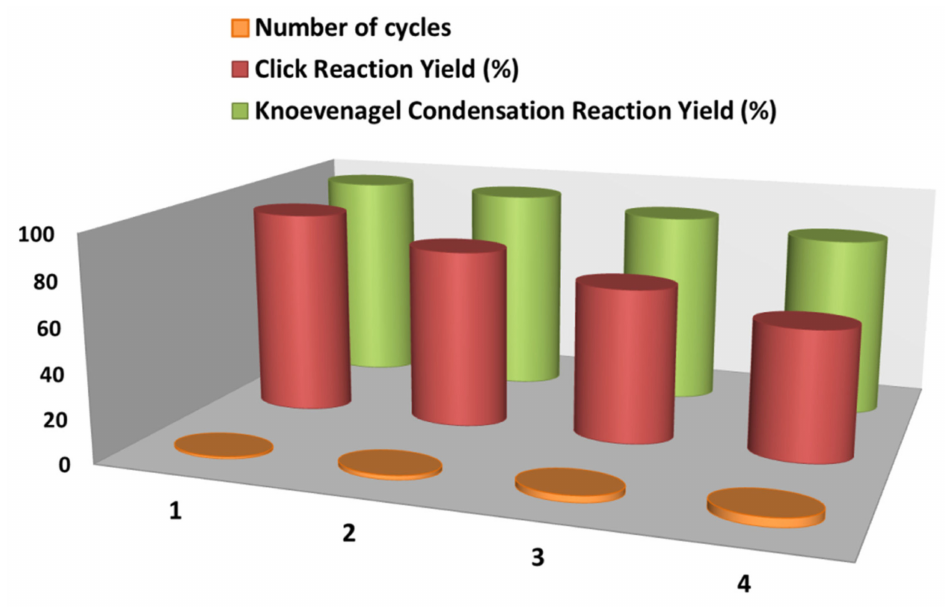
Figure 4. Recyclability chart of Cu-MOF upto 4th cycle.